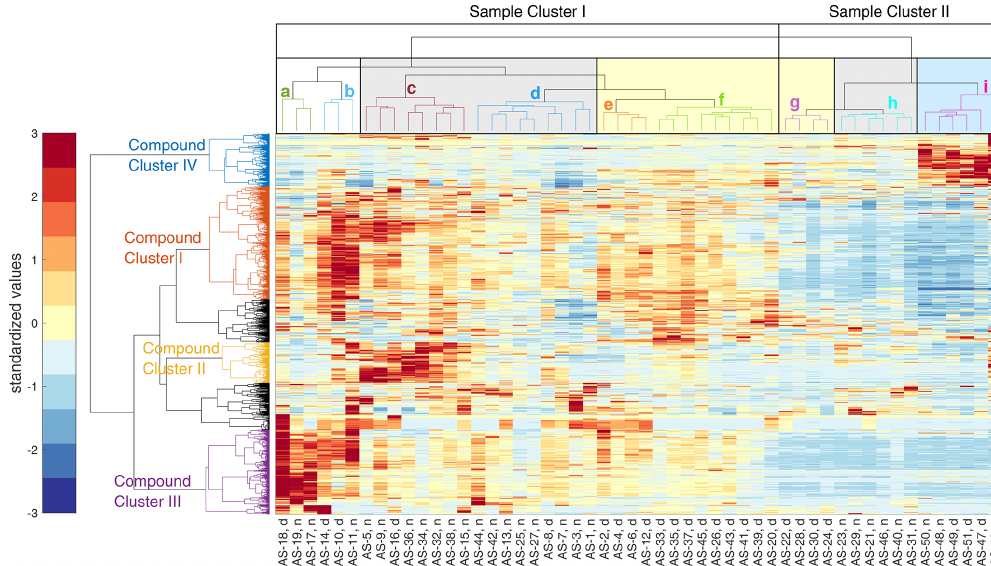
Figure 6. Standardized matrix of the detected compounds from the NTA of the filter samples from the Vienna field campaign. Parts of the horizontal dendrogram of the filter samples are shaded in gray for night cluster, yellow for day cluster, and blue for clustered samples at decreasing temperatures. The vertical compound clusters are separated into four subclusters according to day- and nighttime chemistry, organosulfates, and temperature dependency. For a better differentiation, the dendrograms are colored